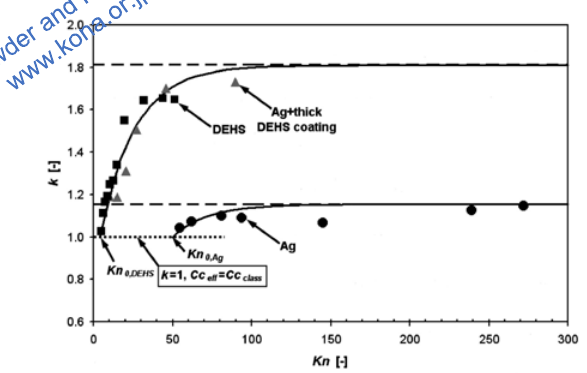
Fig. 10 The factor k as a function of the Knudsen